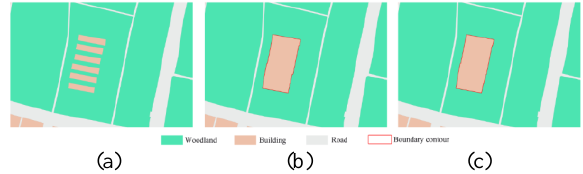
Figure 8. Comparison of aggregation results for the simple linear pattern. (a) Original data; (b) result of mixed integer programming method; (c) result of the method proposed in this paper.